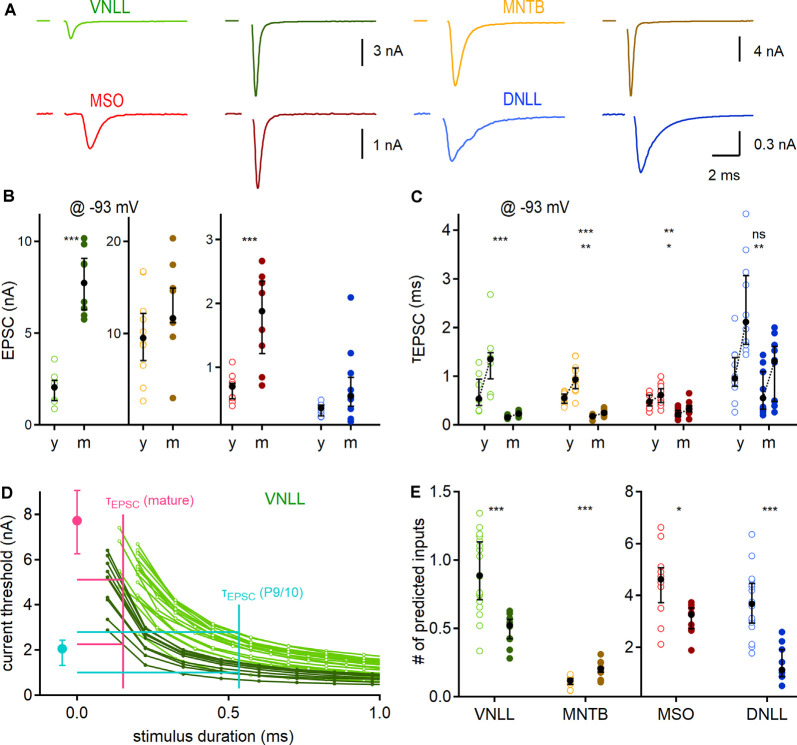
Developmental maturation of synaptic properties and predicted influence on output generation. (A) Exemplary EPSC forms of P9/10 (left) and mature animals (right; VNLL: P23, MNTB: P91, MSO: P65, DNLL: P63) of the four auditory brainstem nuclei. (B) Peak EPSC size, recorded at −93 mV. (C) Maturation of EPSC kinetics. Pair-wise fast (left) and weighted (right) decay time constants recorded at −93 mV. Asterisks on the top show the significance level of fast, and asterisks on the bottom of the weighted time constant values between P9/10 and mature neurons. (D) Strength-duration curves as a dose-response curve for inferring relevant threshold currents. The median fast decay time constant was used as a proxy for stimulus duration (x-axis) to infer the current threshold (y-axis) for action potential generation in strength-duration curves (vertical lines of cyan: P9/10; and magenta: mature). Median EPSC sizes for P9/10 (cyan) and mature VNLL neurons (magenta). Horizontal cyan and magenta lines show maximal and minimal inferred current thresholds. The strength-duration curves are reproduced as a magnification from Figure 3B. (E) Predicted minimum numbers of afferent fibers for postsynaptic supra-threshold excitation. Number of recorded neurons for VNLL: y; n = 7, m; n = 8, MNTB: y; n = 10, m; n = 9, MSO: y; n = 11, m; n = 8, DNLL: y; n = 10, m; n = 10. Markers and color-coding as in Figure 2. Black symbols show the median with the first and third quartiles. ns = not significant, *p < 0.05, **p < 0.01, ***p < 0.001.